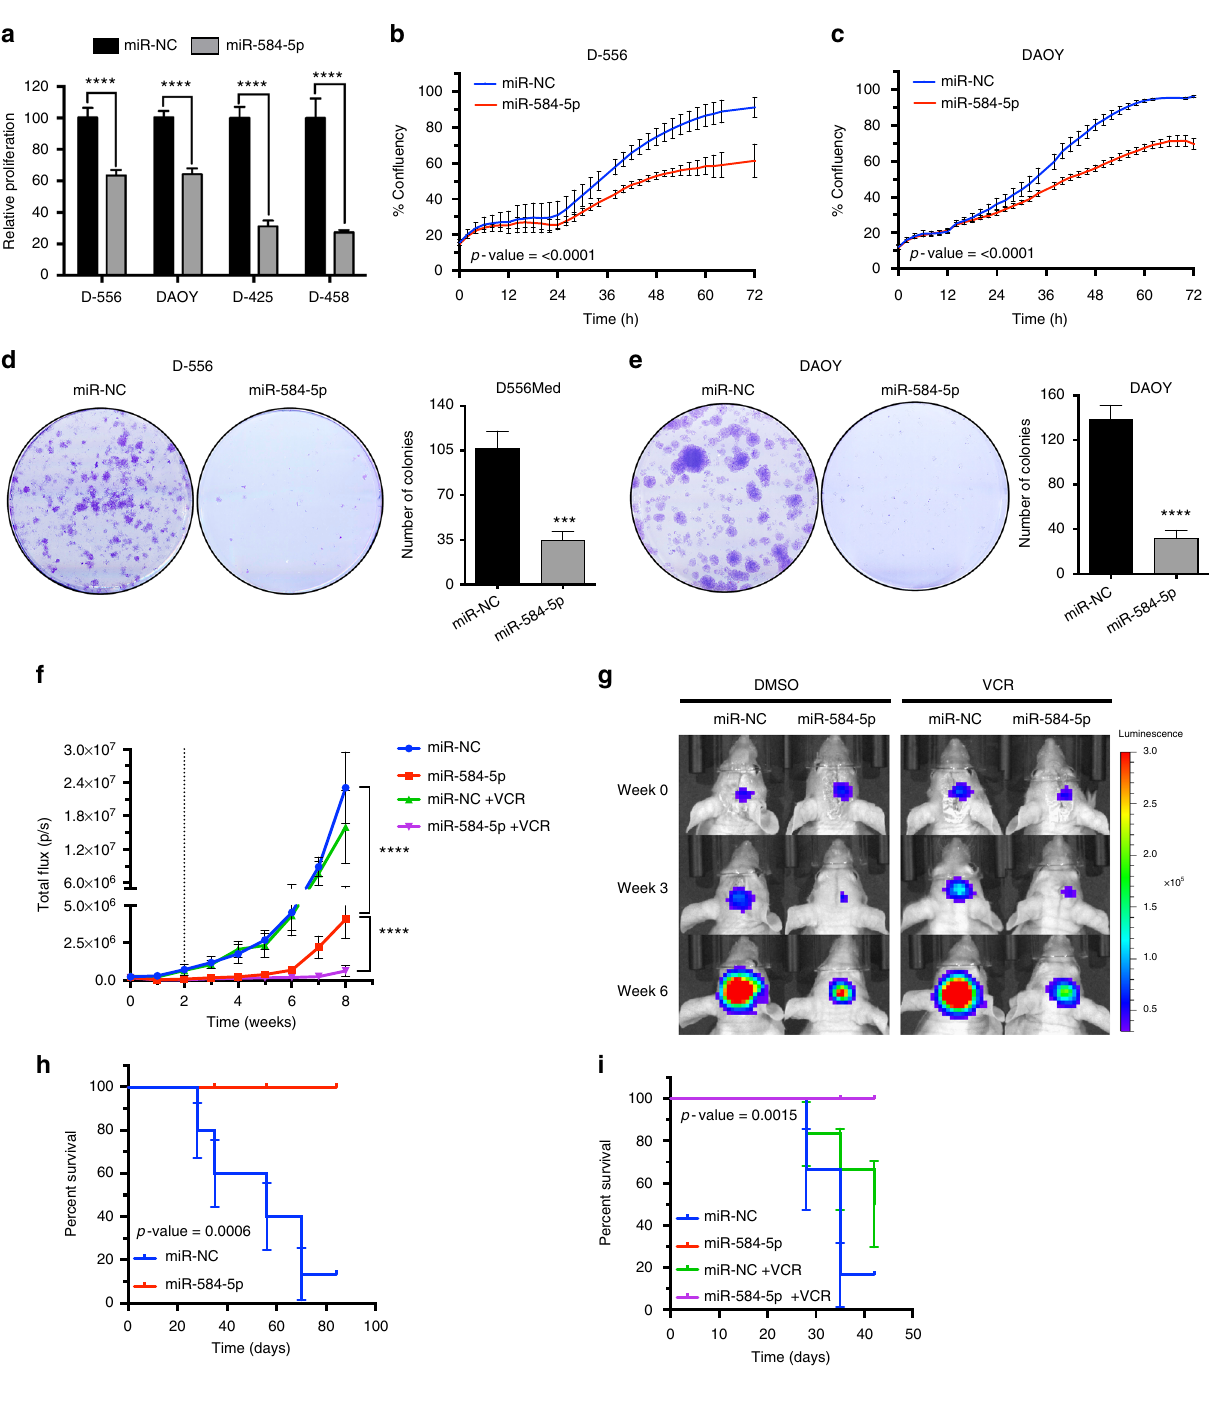
transplantation of the negative control miRNA (miR-NC) and (Fig. 2h, i). To further substantiate those results, we tested the miR-584-5p -transfected DAOY cells stably expressing green potency of miR-584-5p in inhibiting medulloblastoma growth fl uorescent protein (GFP) – luciferase. MiR-584-5p transfectant using inducible miR-584-5p expression system. tumors showed signi fi cantly reduced MB growth in comparison DAOY – GFP – luciferase cells were stably transfected with tet-on with miR-NC-transfectant tumor (Fig. 2f, g) suggesting that miR- shControl and shMiR-584-5p expression vectors and treated with 584-5p acts as a potent tumor suppressor in MB. Furthermore, doxycycline to ensure induced expression of miR-584-5p (Fig. 3a, combination therapy of miR-584-5p and a sub-lethal dose of VCR b). The tet-on shControl and shMiR-584-5p stably expressing signi fi cantly reduced tumor growth in comparison with either cells were then intracranially implanted and after tumor reached a miR-584-5p or VCR alone (Fig. 2f, g). Consistent with that measurable size miR-584-5p expression was turned on by adding fi nding, mice treated with miR-584-5p and miR-584-5p – VCR doxycycline to the drinking water. Induction of miR-584-5p lived signi fi cantly longer than the miR-NC-transfectant group expression resulted in signi fi cantly reduced medulloblastoma NATURE COMMUNICATIONS| (2018) 9:4541 |DOI: